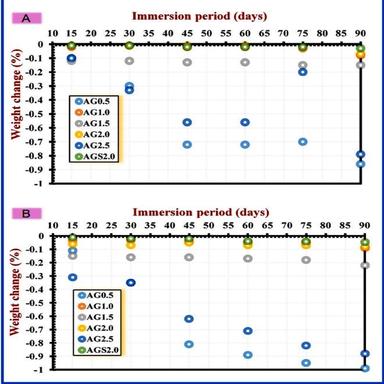
Weight change verses immersion time trends for different geopolymer coating mixtures accomplished for 90 days. (A) Static water immersion plots and (B) Static salt water immersion plots.